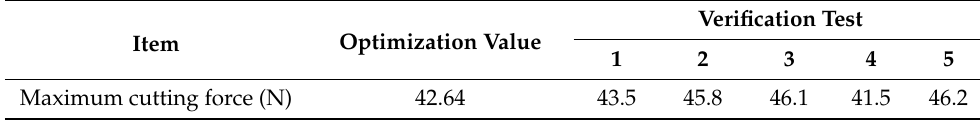
Table 6. Bench test results.